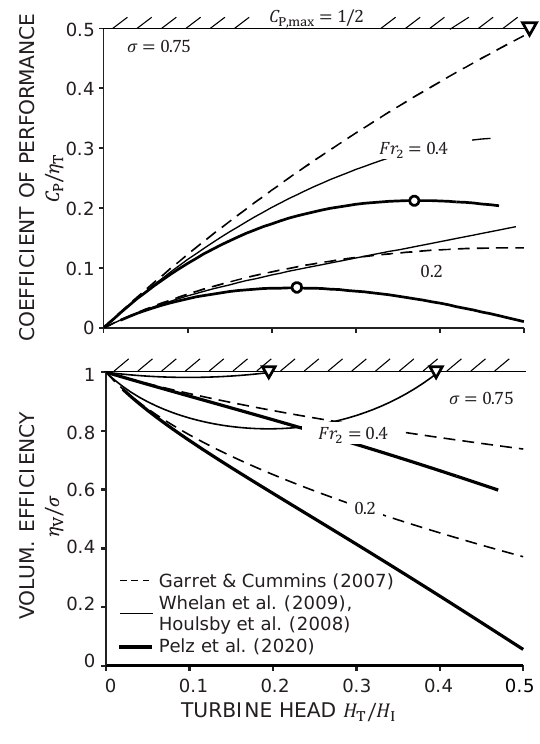
Fig. 7. Coefficient of performance (top) and specific volumetric efficiency (lower graph) versus turbine head H T /H I for a single turbine with blockage of σ = 0 . 75 . The bold lines represent turbine model (iii), the thin lines model (ii) and the dashed lines turbine model (i). The conflict with the energy (top) and the continuity equation (lower graph) are marked with a triangle (adapted from